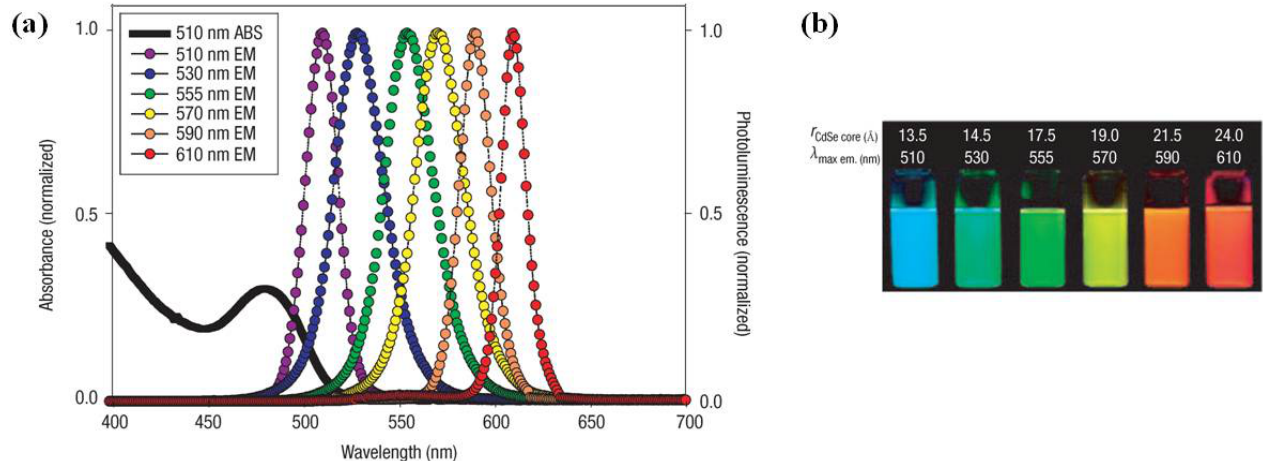
Figure 1. ( a ) Absorption and emission of six different quantum dot (QD) dispersions. The black line shows the absorption of the 510 nm emitting QDs. Note that at the wavelength of lowest absorption for the 510 nm QD, ~450 nm, the molar extinction coefficient is greater than that of rhodamine red at its absorption maxima (~150,000 vs. 129,000 M − 1 cm − 1 ); ( b ) Photo demonstrating the size-tunable fluorescence properties and spectral range of the six QD dispersions plotted in A vs. CdSe core size. All samples were excited at 365 nm with a UV source. For the 610 nm emitting QDs, this translates into a Stokes shift of ~250 nm. r = radius. Reprinted with permission from [5]. Copyright 2005 Nature Publishing